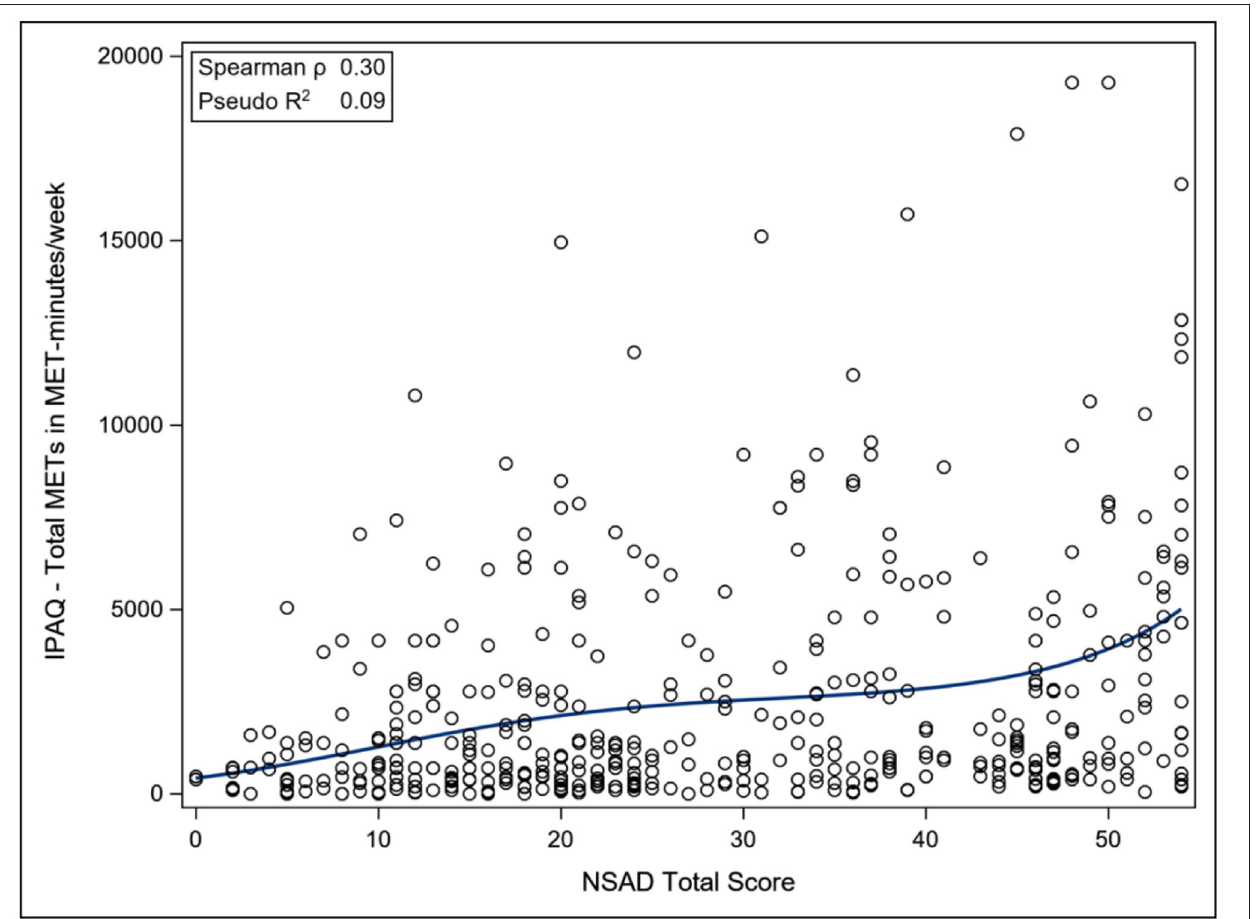
FIGURE 4 | Association between total NSAD score and IPAQ. NSAD, North Star Assessment for Limb Girdle Type Muscular Dystrophies; IPAQ, International Physical Activity